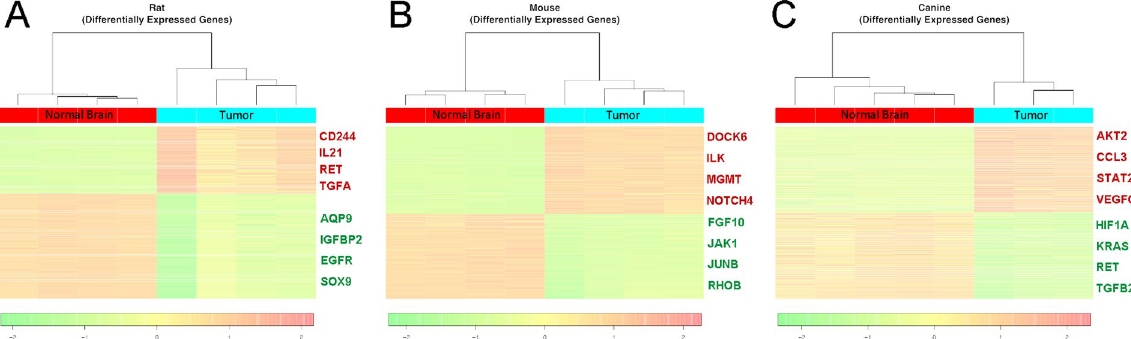
Figure 1. Differential gene expression in PDGFRA-overexpressing rat, mouse, and canine in situ -formed gliomas. Heatmaps representing the degree of variation and clustering of gene expression between control, normal brain tissue (red bar) and tumor tissue (blue bar). ( A ) RCAS/TV-A rat gliomas: there were 1,710 DEGs in total; this included 661 up-regulated genes and 1,049 down-regulated genes. Several examples of glioma- associated DEGs that were upregulated or downregulated specifically in the rat model are listed. ( B ) RCAS/ TV-A mouse gliomas: there were 3,223 DEGs in total with 1,658 up-regulated and 1,565 down-regulated in tumor tissue compared to normal brain. Several examples of glioma-associated DEGs that were upregulated or downregulated specifically in the mouse model are listed. ( C ) Spontaneous canine glioma: there were 4,166 DEGs in total with 2,109 up-regulated and 2,057 down-regulated in tumor tissue compared to normal brain. Several examples of glioma-associated DEGs that were upregulated or downregulated specifically in dogs are listed. [Scale bar representing graded fold change in gene expression: red = increased expression, green = decreased